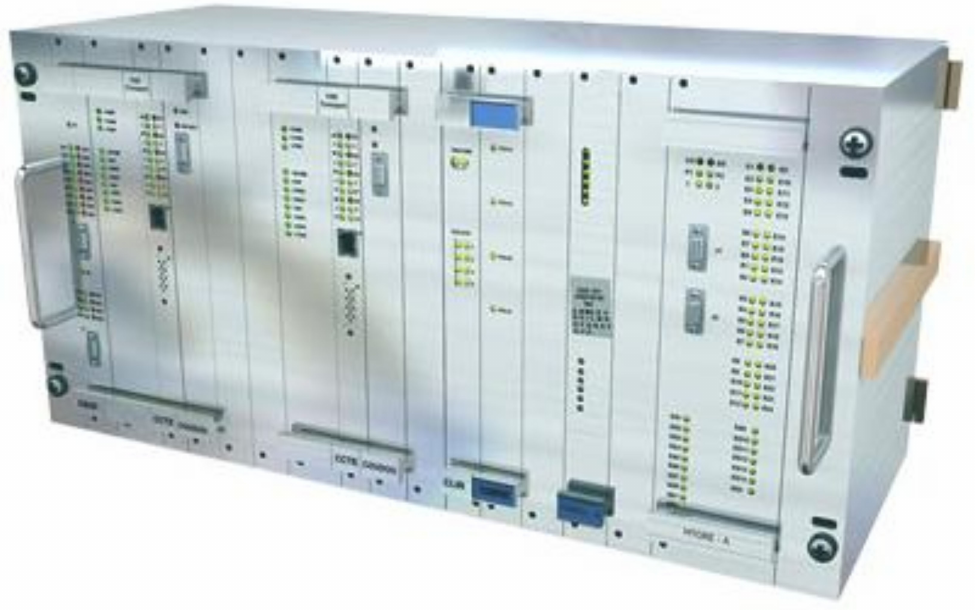
Figure 1. Example of electronic signaling